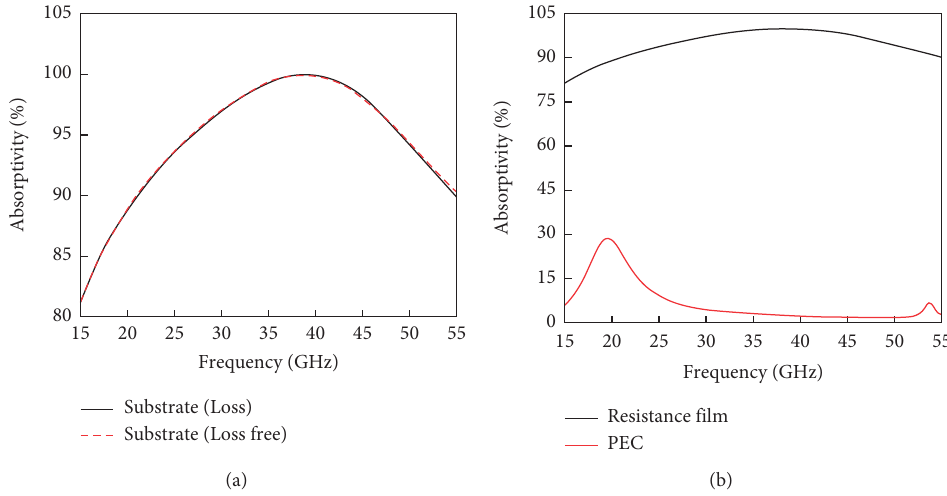
eff and μ eff and (b) imaginary part of ε